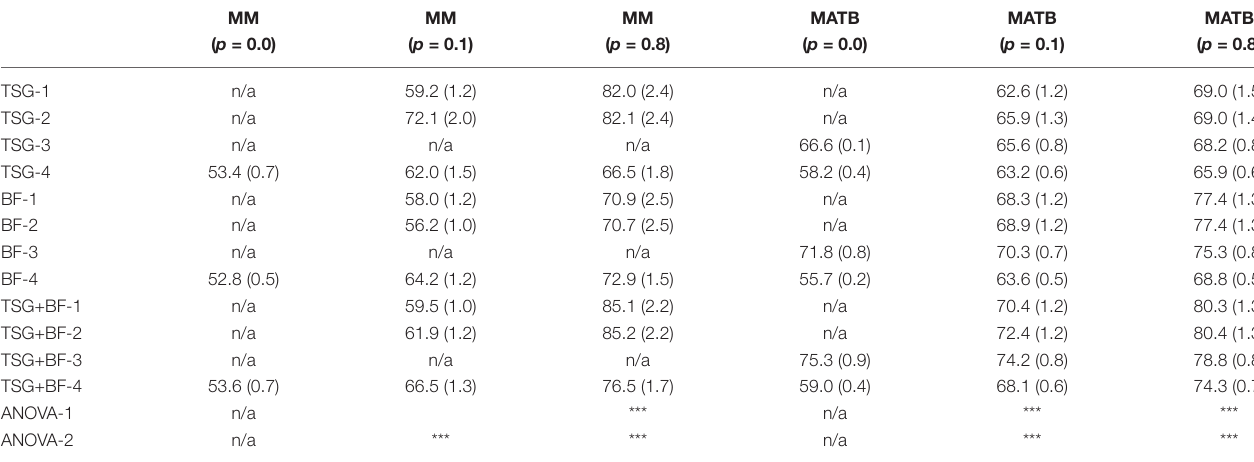
TABLE 1 | Summary table of the in-session, non-constant querying, and transfer results for the Mental Math (“MM”) and MATB-II (“MATB”) datasets.